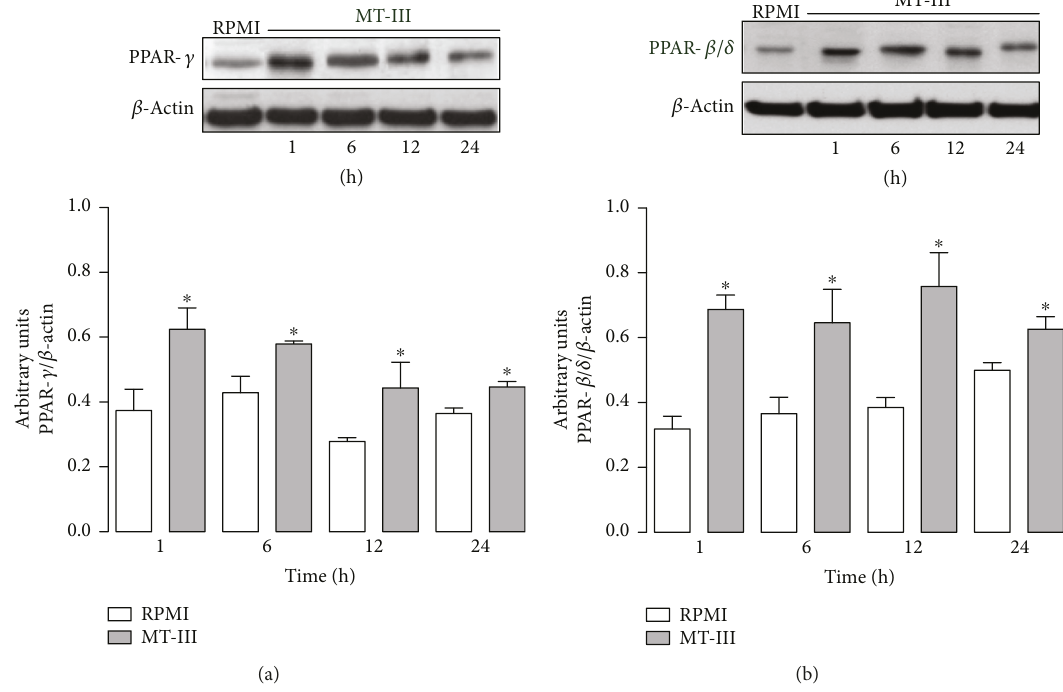
Figure 2: MT-III induces upregulation of PPAR- γ and PPAR- β / δ protein expression in macrophages. Peritoneal macrophages were incubated with MT-III (0.4 μ M) or RPMI (control) for 1, 6, 12, and 24 h. (a, b) Western blotting and densitometric analysis of the band intensities of immunoreactive PPAR- γ (a) or PPAR- β / δ (b) and β -actin (loading control) in macrophage extracts. Results are expressed as mean ± SEM from three experiments. ∗ p < 0 05 compared with